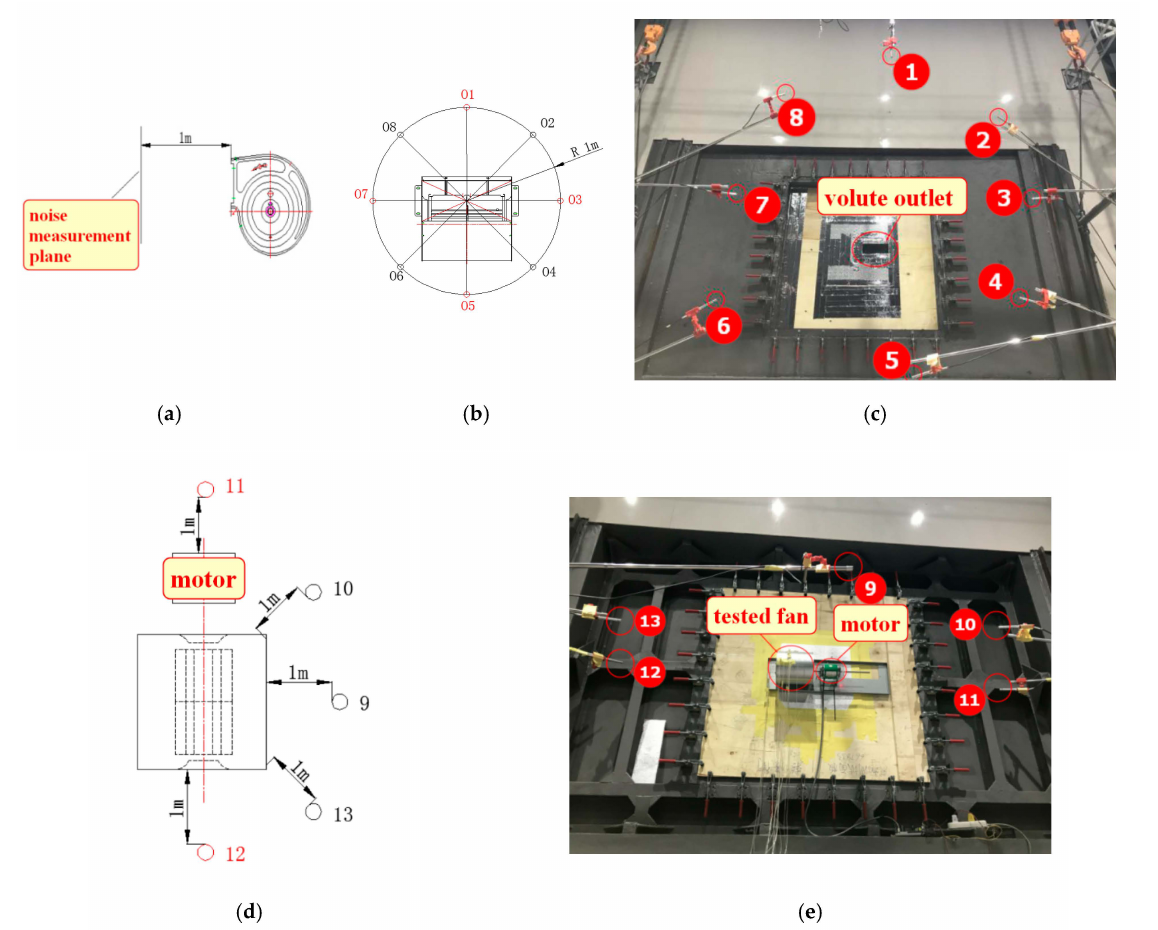
Figure 6. Location of noise measurement at the fan inlet and outlet. ( a ) Noise measurement plane of the outlet, ( b ) noise measuring points of the outlet, ( c ) layout of outlet-noise microphone, ( d ) measur- ing points of the inlet noise, and ( e ) layout of inlet noise microphone.